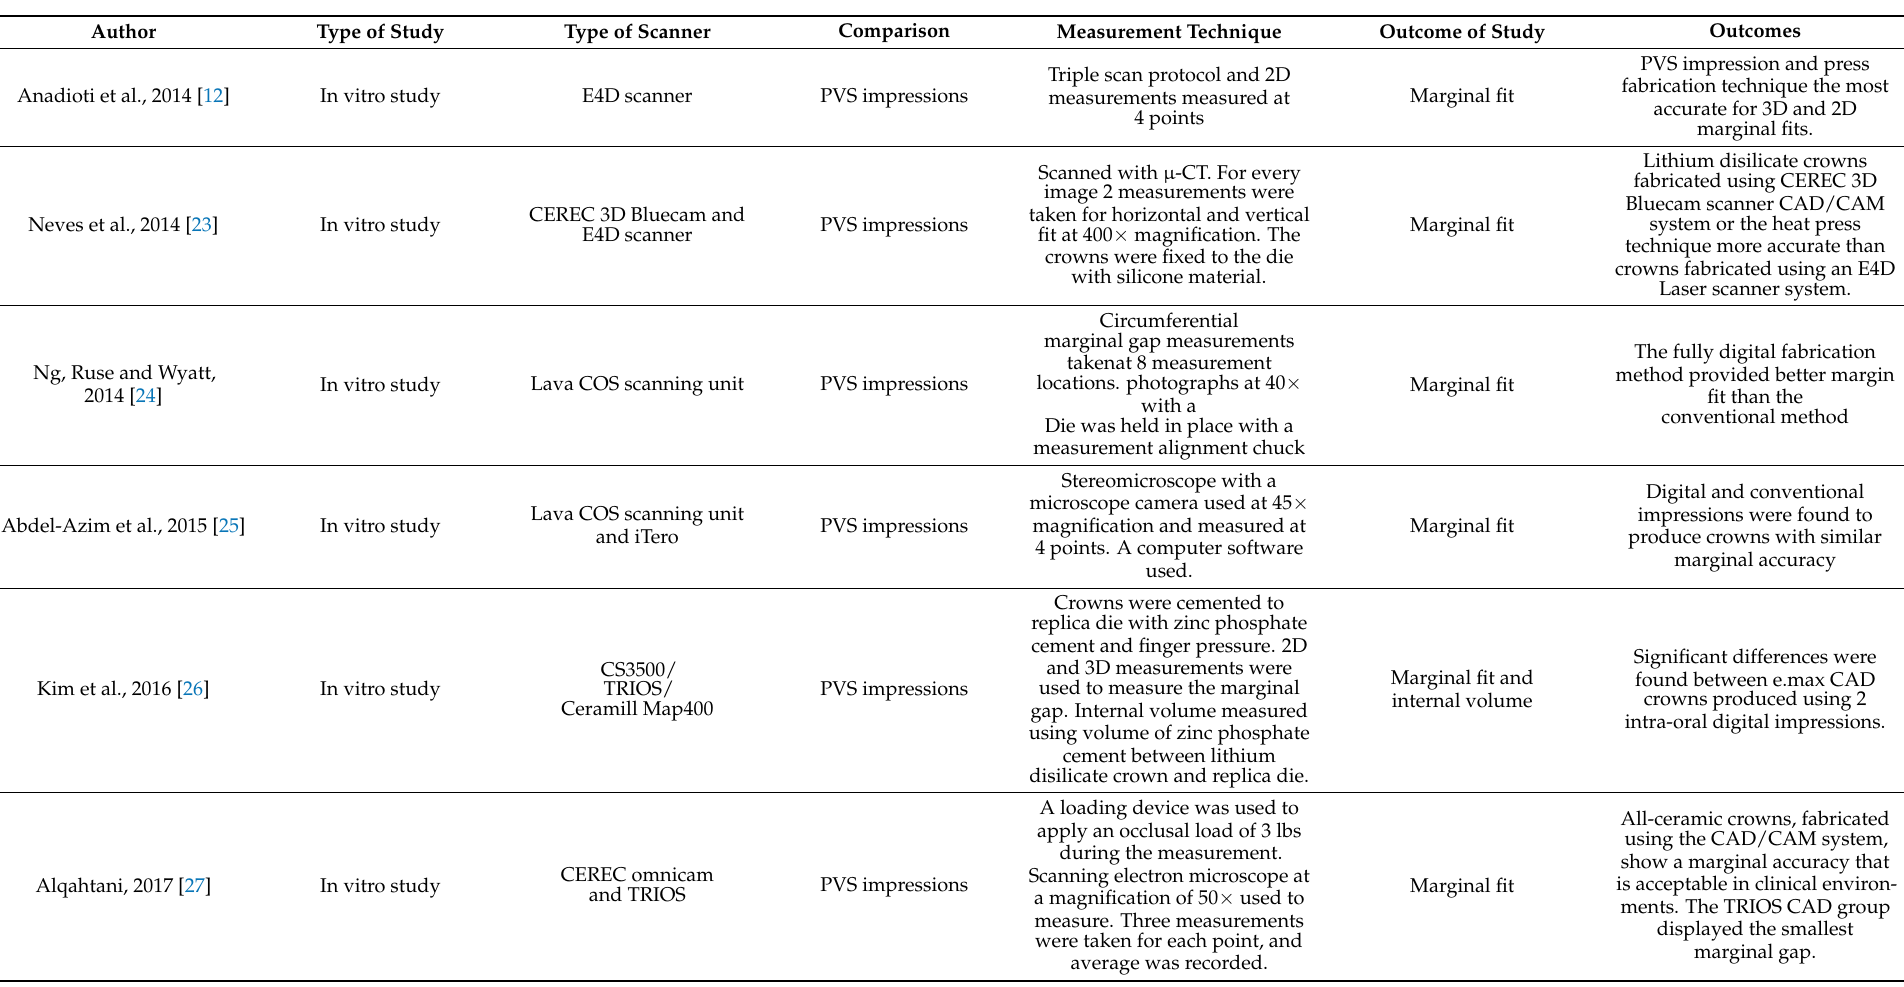
Table 6. Illustrates Characteristics of the included